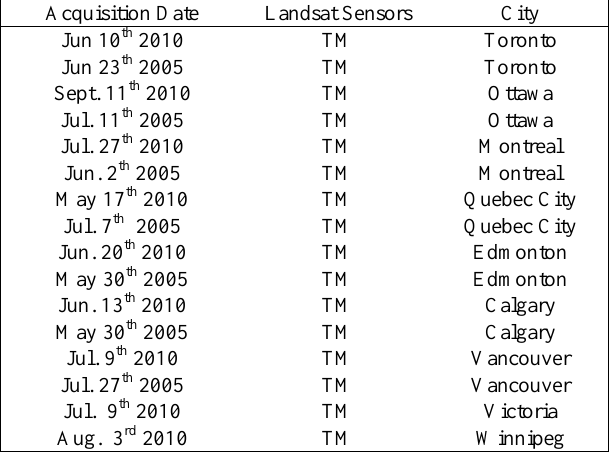
Table 1. Multi-temporal Landsat satellite images for 2010 and